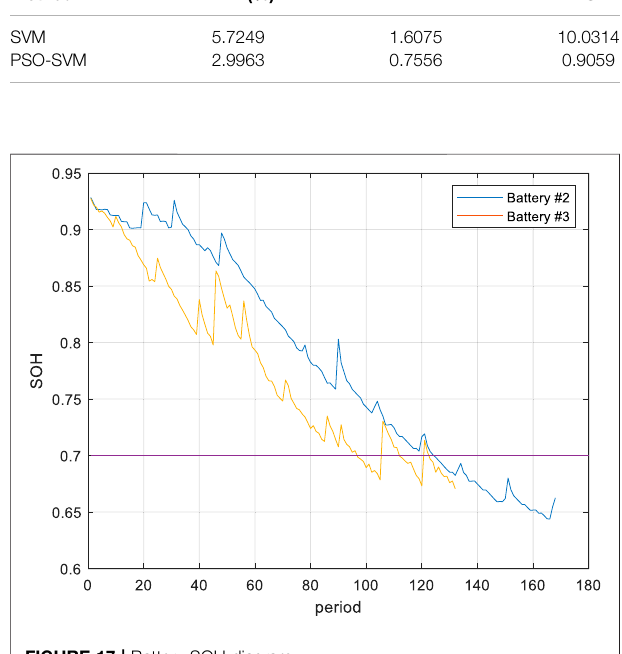
FIGURE 17 | Battery SOH